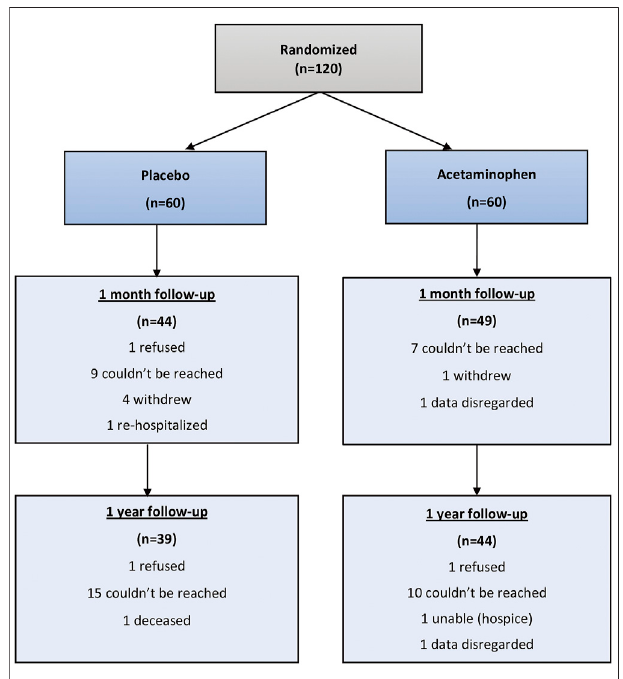
FIGURE 1 | Consort